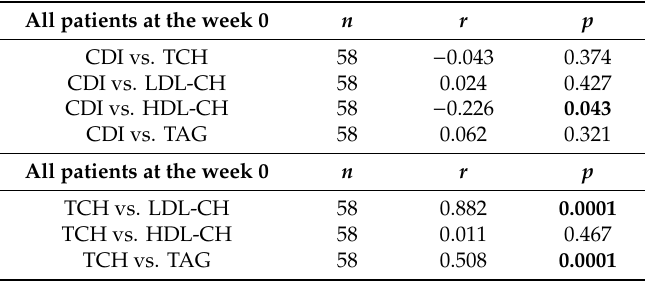
Table 2. Correlations between CDI score and lipid profile parameters, and LDL- and HDL-subfractions. All patients at the week